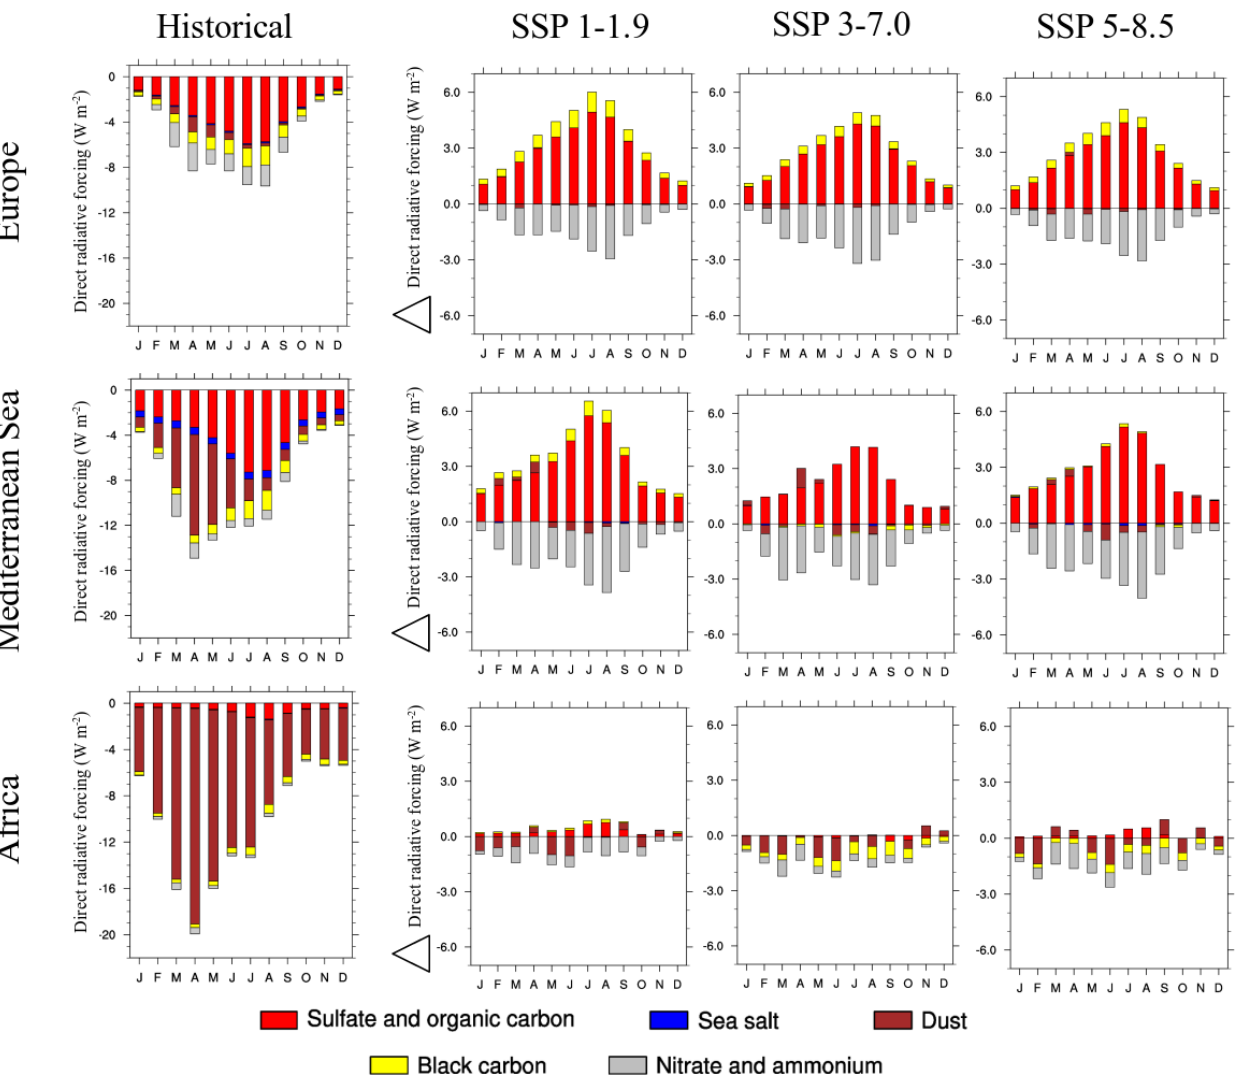
Figure 10. Surface SW DRF evolution (Wm − 2 ) of sulfate and organic carbon (in red), sea salt (in blue), dust (in brown), black carbon (in yellow) and nitrate and ammonium (in grey) between the historical period (1971–2000) and the future period (2021–2050) according to SSPs 1-1.9, 3-7.0 and